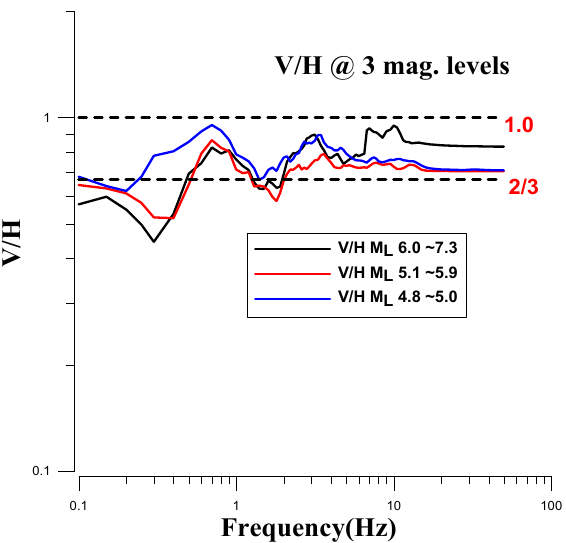
Figure 10. Mean V/H ratios of the 8 seismic stations for three groups of earthquake magnitude: M L 6.0–7.3 (black solid), 5.3–5.8 (red solid), and 4.6–5.0 (blue solid), respectively. The x -axis represents frequency and the y -axis the V/H ratios.